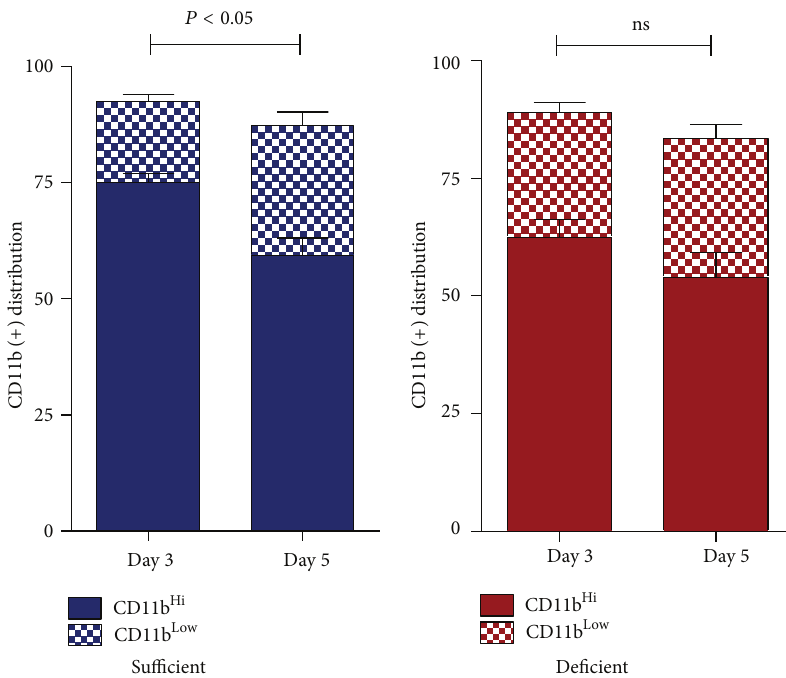
Figure 5: Vitamin C influences macrophage phenotype during resolution of inflammation. Flow cytometry for distribution of CD 11 b high and CD 11 b low population from macrophages isolated on day 3 and day 5 following TG-induced peritonitis in VitC sufficient or deficient mice ( 𝑁 = 5 mice/group, 𝑃 < 0.05 , CD 11 b low day 3 versus day 5, ns = not